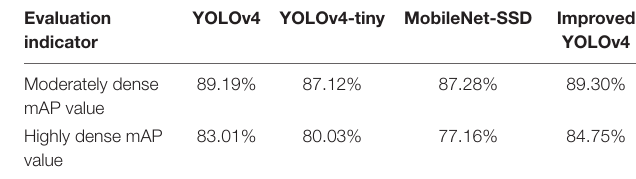
TABLE 5 | The detection results of different density in four